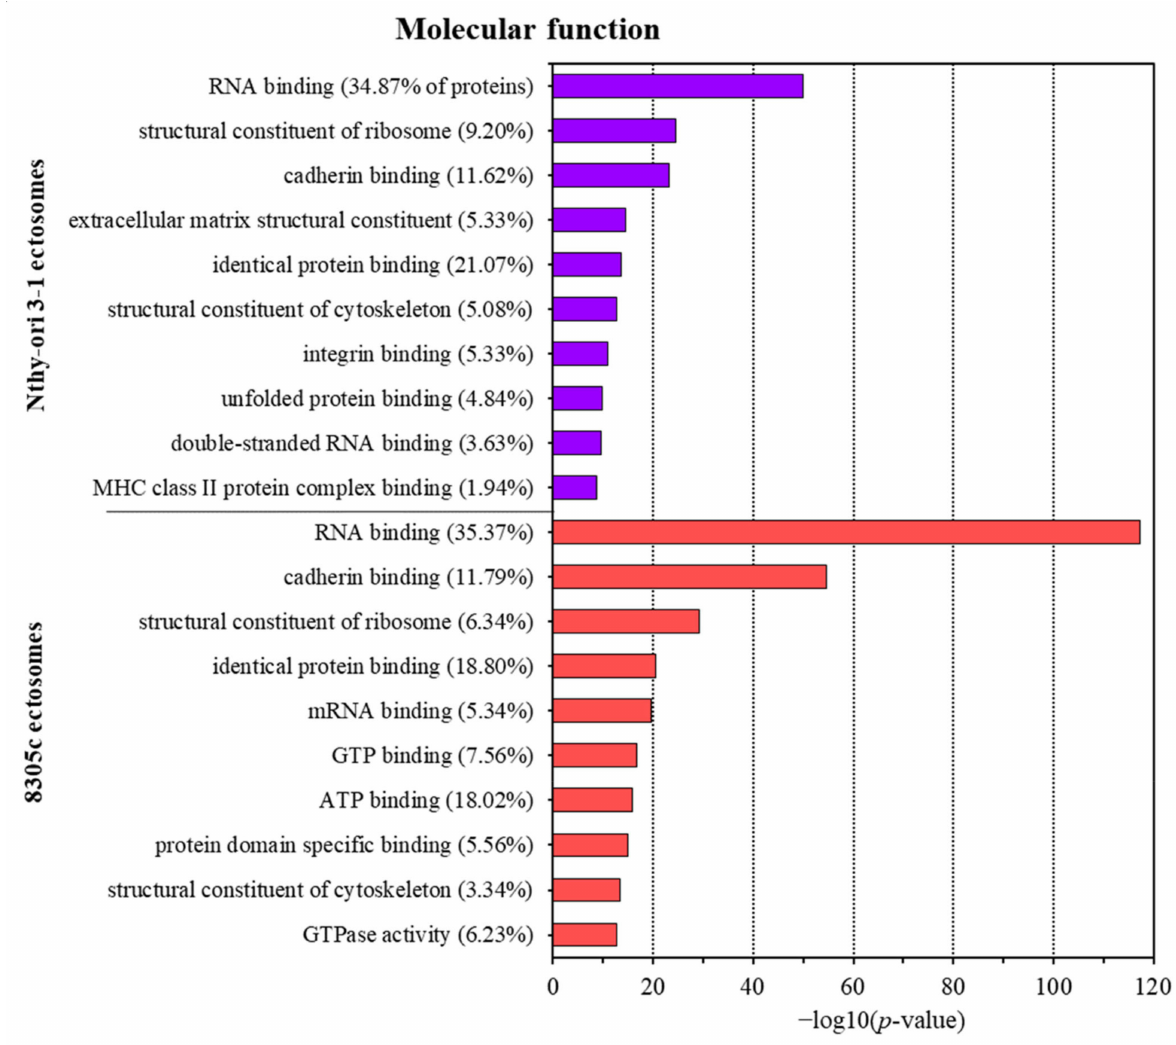
Figure 5. Gene ontology (GO) analysis of proteins identified in ectosomes derived from normal thyroid follicular epithelial Nthy-ori 3-1 cells and thyroid anaplastic carcinoma 8305C cells performed with the use of FunRich 2.0 software with UniProt database (release April 2021) as a reference. For GO term “molecular function”, 10 categories with the highest statistical significance of protein enrichment within the specific category ( p < 0.001) are presented as graphs. Complete results of GO analysis are provided in Supplementary Data